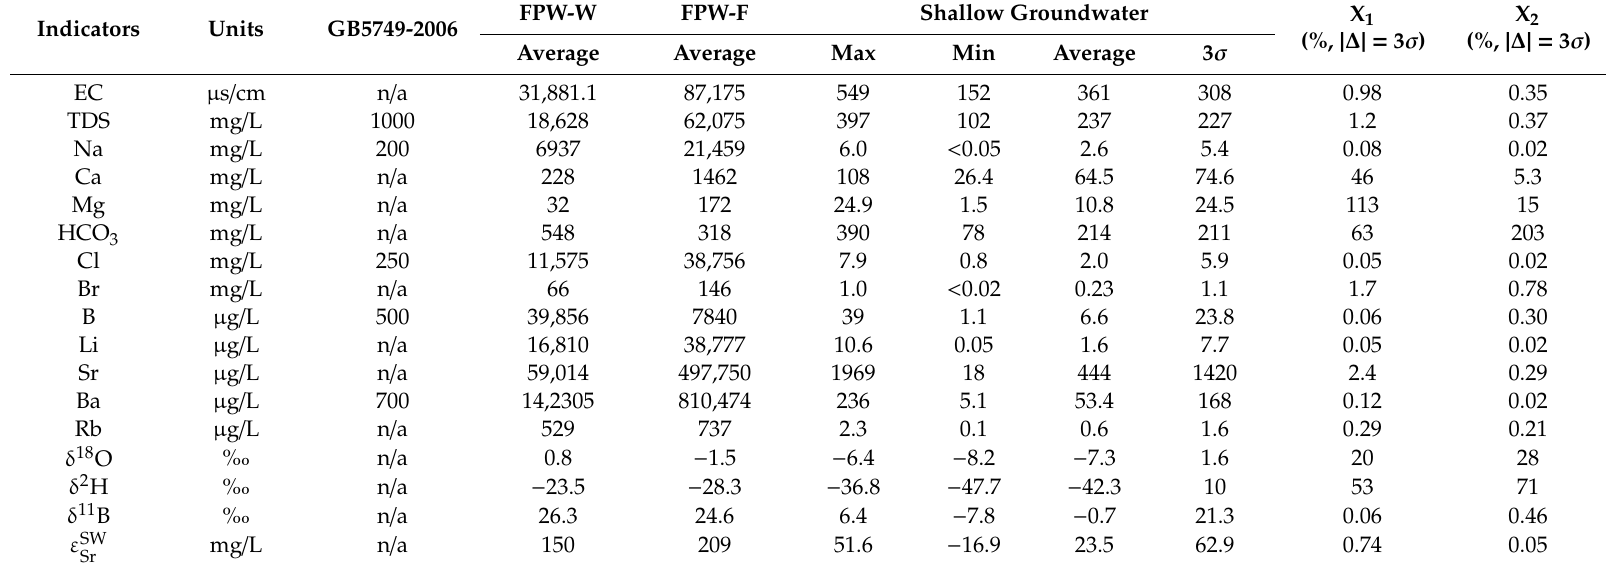
Table 3. The threshold values of specific ions and their isotopes during the mixing process between shallow groundwater from Xishui and FPW-W or FPW-F. X 1 represents the threshold value for identifying the mixing of FPW-W, while X 2 stands for threshold values for recognizing the mixing of FPW-F. GB5479-2006 stands for the drinking water standard of